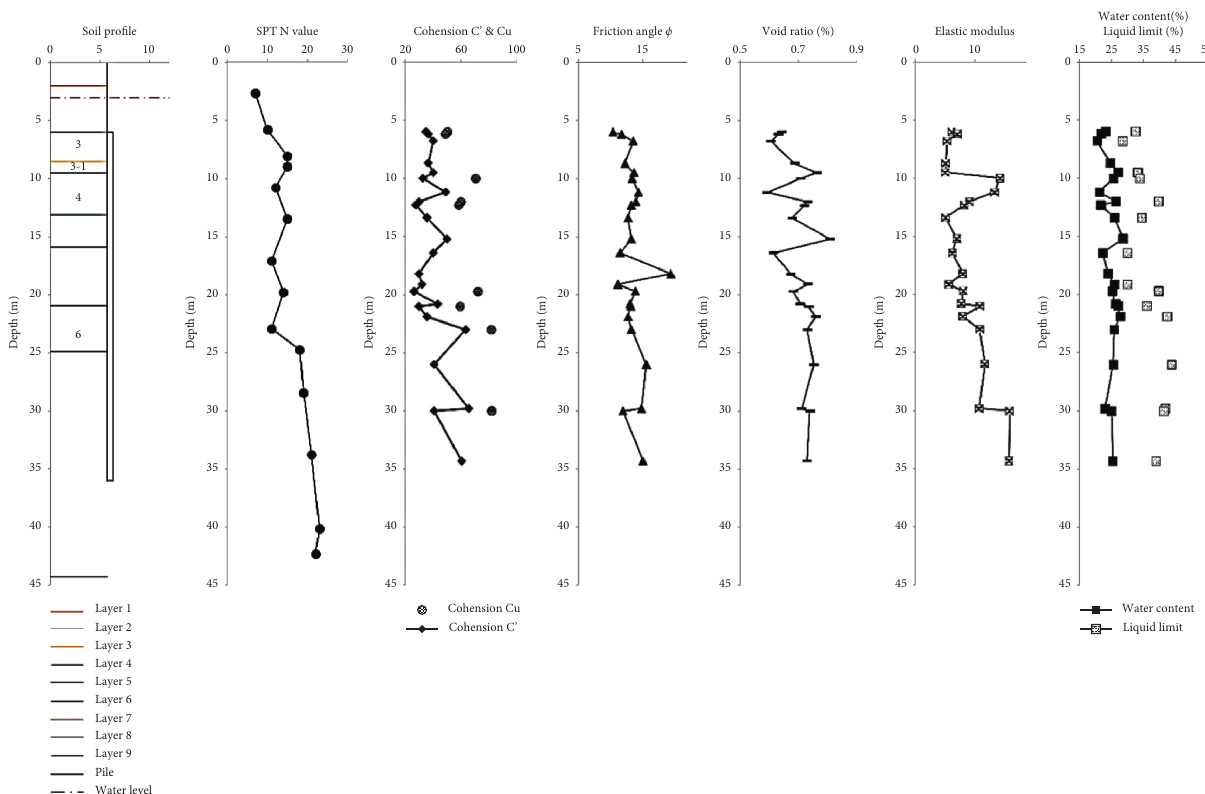
Figure 2: Subsurface conditions of